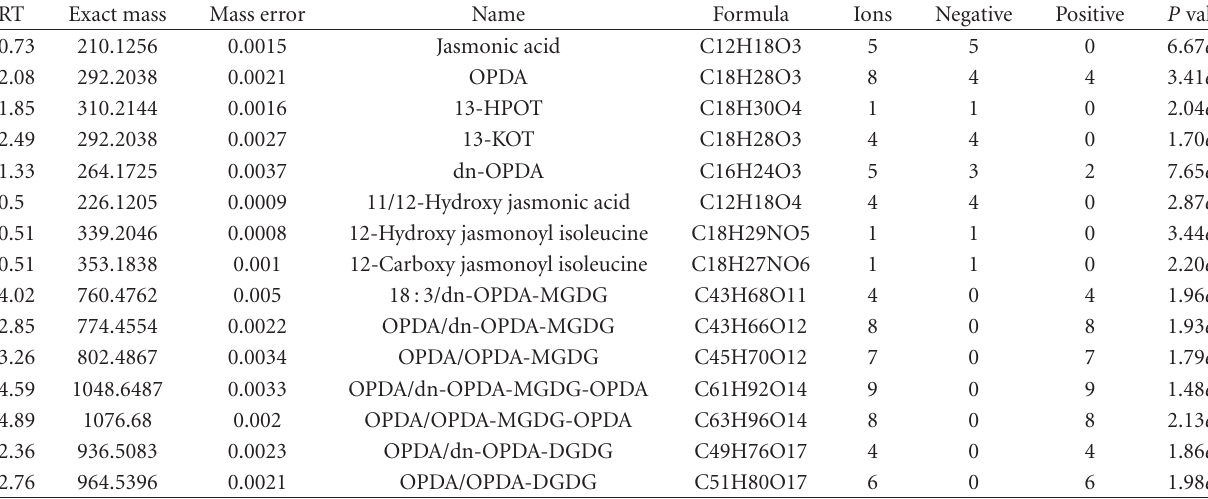
Table 4: Identified metabolites in the combined and filtered data set. The retention time is measured in minutes and the exact compound mass is stated in Dalton. The columns “Negative” and “Positive” contain the number of associated marker candidates/ions obtained in the negative or positive ionization mode. The column “Ions” contains the sum of associated marker candidates/ions per compound. The column “ P value” contains the minimal adjusted P value of the Kruskal-Wallis test over all associated marker candidates, respectively. The column “Mass error” contains the absolute di ff erence between the corrected mass of the marker candidate with the minimal adjusted P value and the exact compound mass in Dalton.